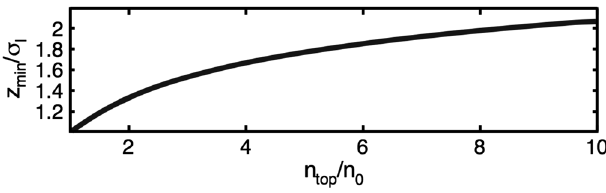
FIG. 1. (a) Gaussian density down-ramp (black) (with ~ n σ ¼ 2 . 5 ) and phase velocity of the plasma wave (red) at 10 and k 0 l p the phase-position χ ¼ − 2 π , as a function of the distance with respect to the top of the ramp. The maximum velocity of the plasma electrons driven by Gaussian electron beams with 1, 2.5 and 5.0 kA of peak current, as a function of the plasma density is also shown for comparison. (b) Minimum phase velocity at χ ¼ − 2 π as a function of the ramp parameters ~ n (color map). The maximum velocity of the plasma electron for 1, 2.5 and 5.0 kA electron drivers is also shown as red contours.